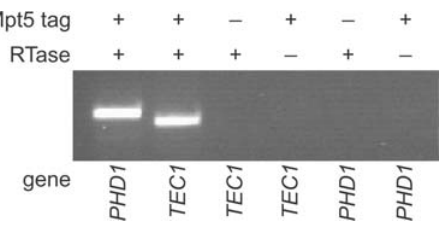
Figure 2. In vivo TEC1mRNA binding by Mpt5 . An immunoprecipitate of epitope-tagged Mpt5 protein was subjected to reverse transcription and gene-specific polymerase chain reaction to detect the presence of bound mRNAs. Control experiments lacked either the epitope tag or reverse transcriptase.